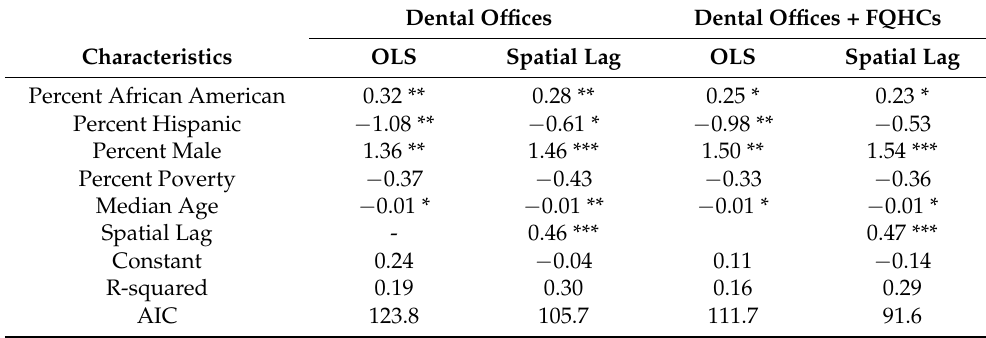
Table 3. Regression Results ( n = 179 census tracts).